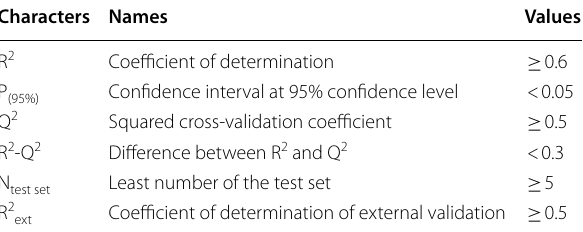
Table 6 Suggested values used in the assessment of QSAR